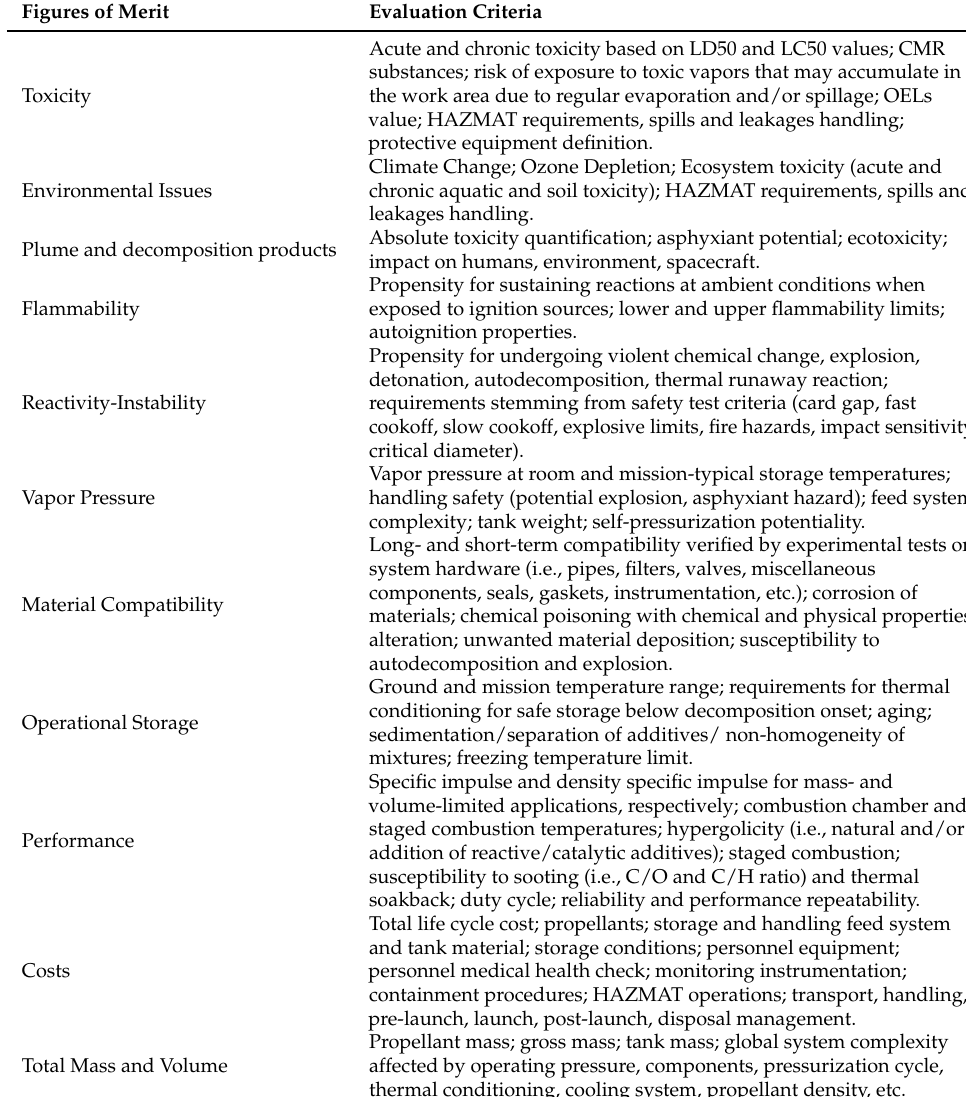
Table 3. Summary of open-literature selection